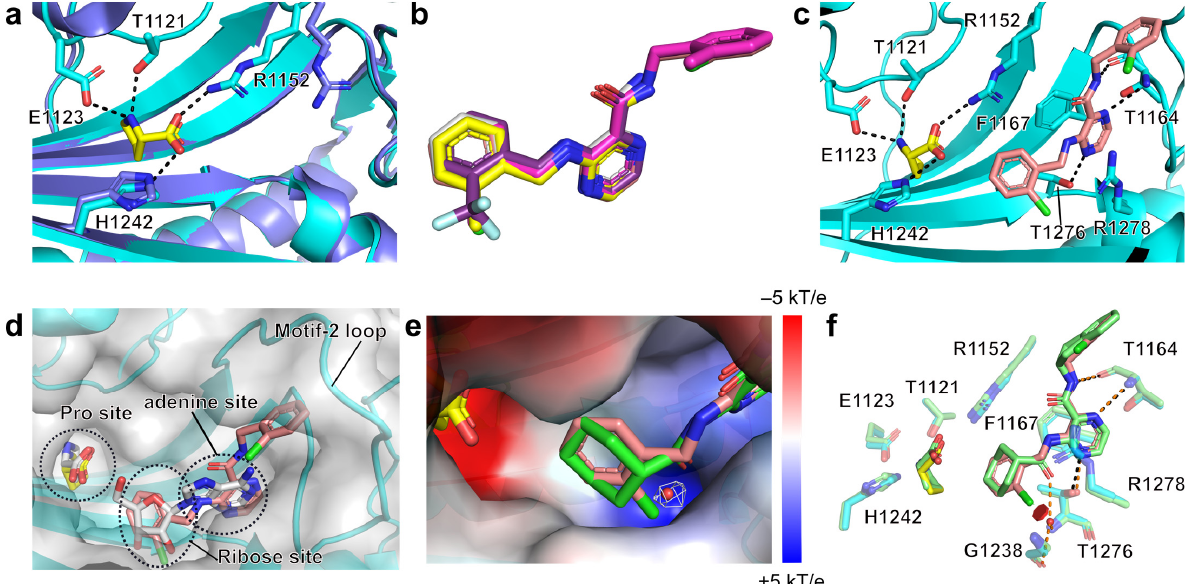
Figure 5. Structural comparison between different ligand-bound structures. ( a ) Superposition of ligand-free (blue; PDB ID: 4K86) and Pro-bound (cyan) HcProRS structures. The important protein residues making directly polar interactions with the substrate Pro are shown as sticks representations. H-bonds and the salt bridge are shown as black dashed lines. ( b ) Protein-based superposition of all five 3-aminopyrazinamide-based ligands. ( c ) The interactions between HcProRS and compound 3b . The residues interacting with Pro and 3b are shown as sticks and H-bonds are shown as black dashed lines. ( d ) Superposition of ternary complexes HcProRS:Pro: 3b (salmon) and HcProRS:Pro:adenosine (grey, PDB ID: 4K87). Pro, adenine and ribose binding sites were highlighted with black dashed circles. The backbone structure of HcProRS:Pro: 3b is shown as cyan cartoon representation surrounded with a transparent surface. Ligands are shown as sticks. ( e ) Electrostatic surface potential of the ligand binding site of HcProRS:Pro: 3b . Compound 2a (green, PDB ID: 5VAD) was superposed onto 3b (salmon) and the structured water molecule of 2a -bound structure is shown as a red sphere that is covered with electron density map contoured at 1 σ and shown as white mesh line. ( f ) Superposition of HcProRS:Pro: 3b (salmon) and HcProRS:Pro: 2a (green) structures. It shows both compounds bind in the same ATP binding site of HcProRS in a Pro-dependent manner. The H-bonds of former and latter structures are shown as black and orange dashed lines, respectively. The water molecule of 2a -bound structure is shown as a red sphere. The 2-Cl of the C3-substituted moiety is clearly sterically excluding the binding of the structured water as seen by the calculated potential steric clash (calculated in Pymol and depicted as a red disk).